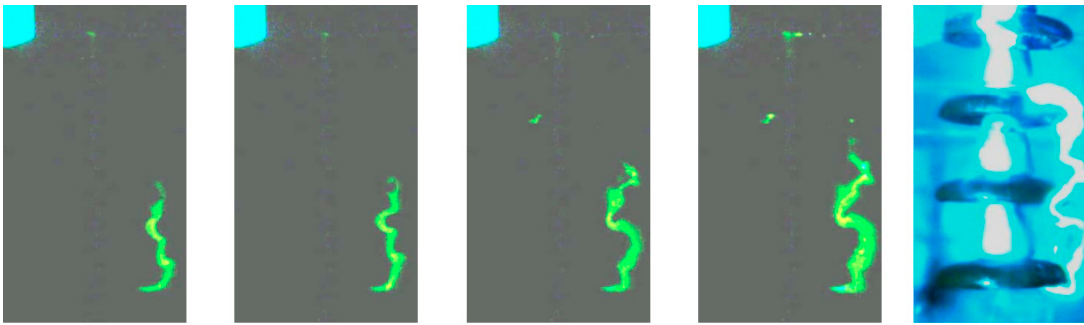
Figure 1. Discharge process of insulator string.